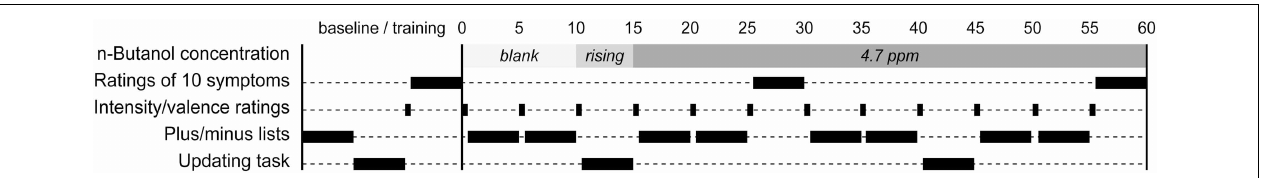
FIGURE 1 | Overview of experimental procedure. The exposure session began at min 0.